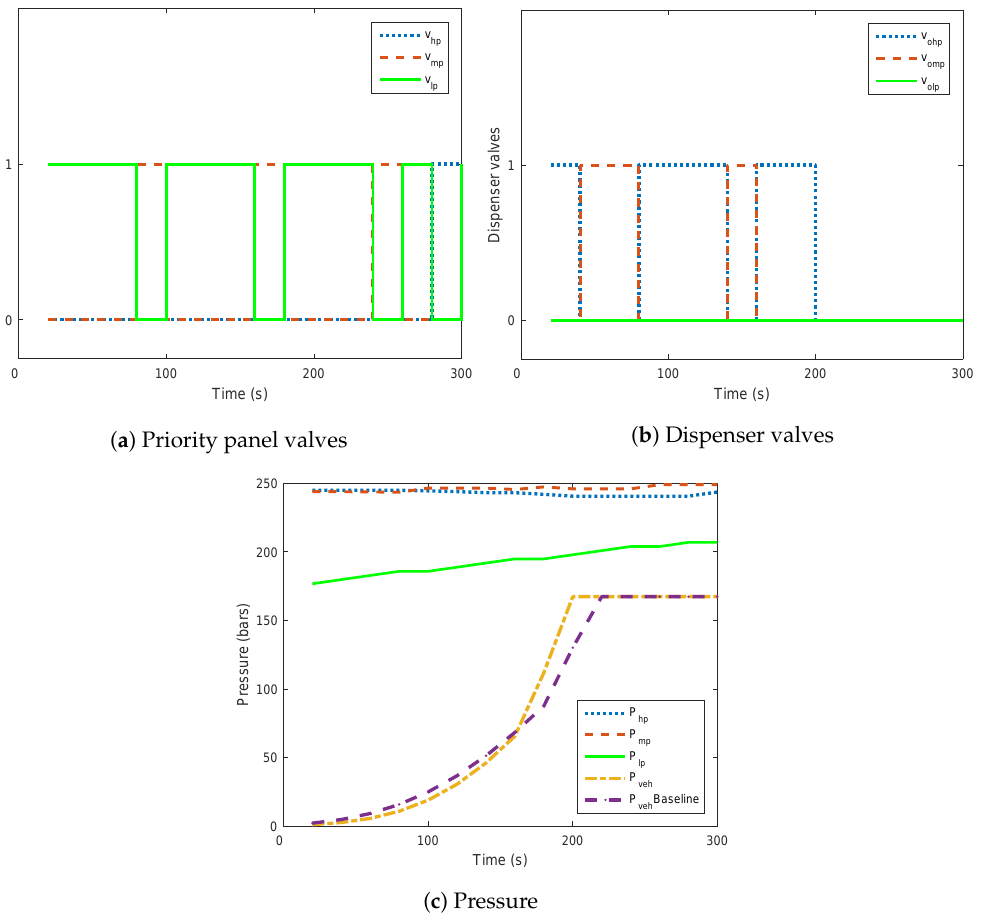
Figure 8. Vehicle filling with the compressor on (38th vehicle of